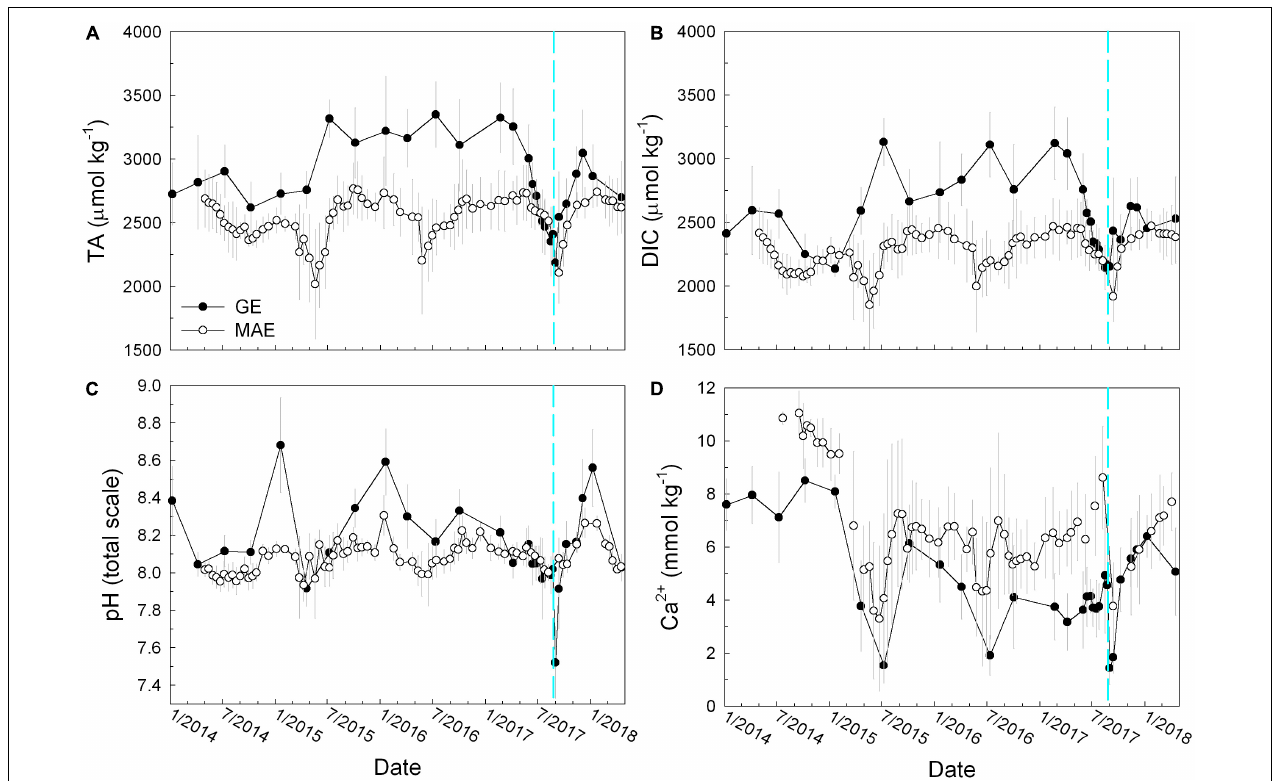
FIGURE 3 | Temporal distributions of (A) total alkalinity (TA), (B) total dissolved inorganic carbon (DIC), (C) in situ pH on total scale, and (D) calcium ion concentration ([Ca 2 + ]). The open circles represent MAE and the close circles represent